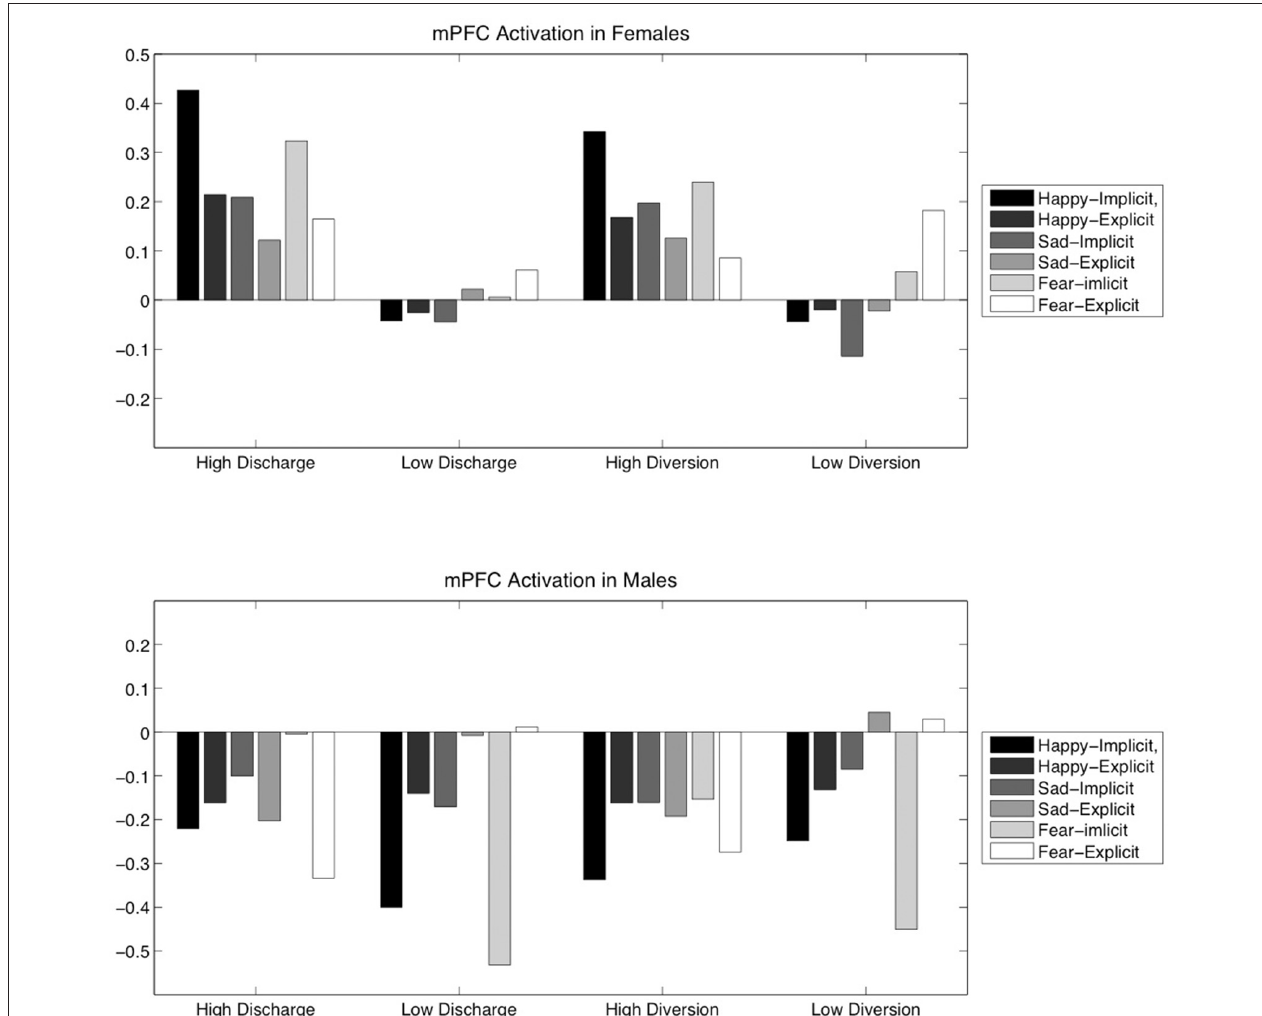
FIGURE 4 | High- and low-score groupings of female and male participants based on either Discharge or Diversion score show differences in mPFC activation, which is shown above by listening condition.